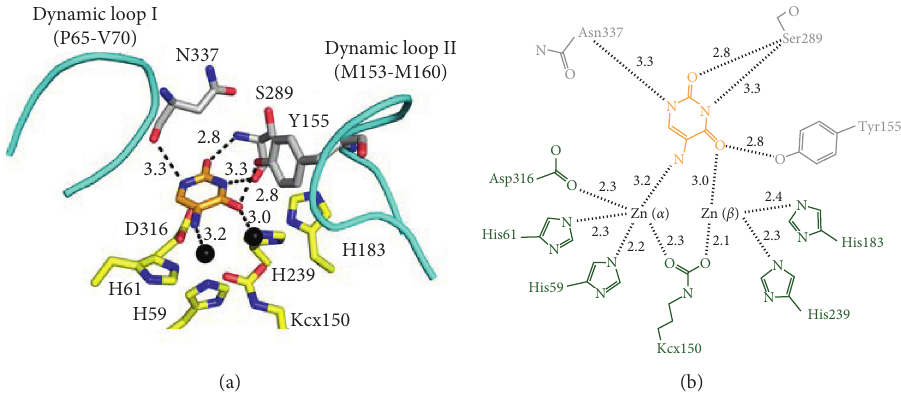
Figure 2: 5-AU binding mode. (a) The interactions of PaDHPase with 5-AU. Two metal ions (black spheres) and the substrate binding sites (gray) in PaDHPase were involved in 5-AU (light orange) binding. Dynamic loops are colored in cyan. 5-AU interacted with the main chains of residues Ser289 and Asn337 and the side chain of residue Tyr155. The distances are shown on dotted lines. (b) 5-AU interacted with Zn α , Zn β , Ser289, Asn337, and Tyr155. Residues (His59, His61, Kcx150, His183, His239, and Asp316) required for metal binding are colored in green.